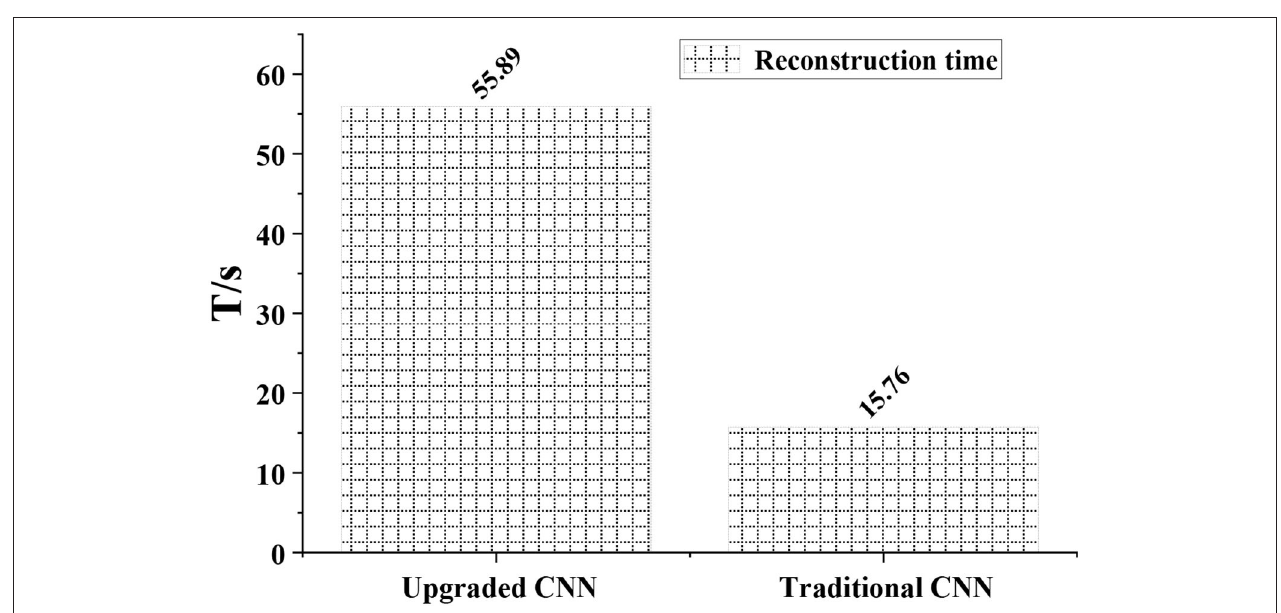
FIGURE 4 | Analysis of reconstruction time of CNN